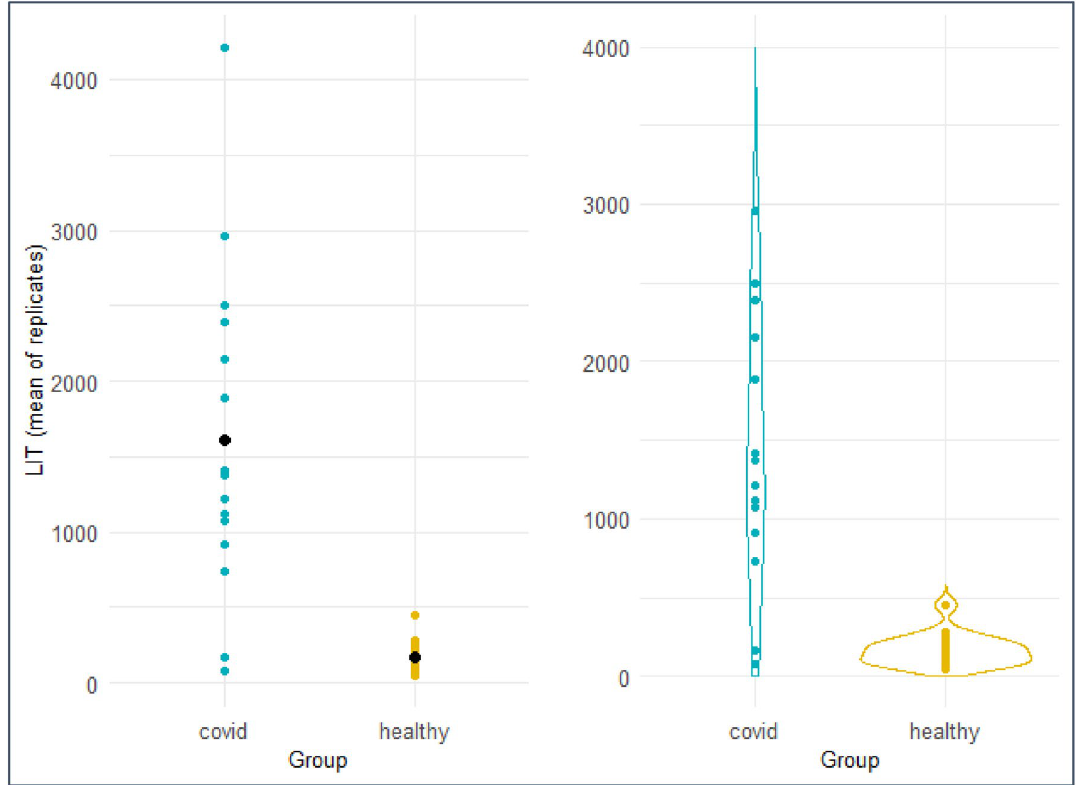
Figure 1. Dot plot (L) and violin plot (R) of LIT scores for patients with COVID-19 or healthy donors. Median LIT score for patients with COVID-19 was 1378 (IQR: 1276) and was ninefold higher than values within the control group (Median 153; IQR: 112, (Mann–Whitney U test, p <